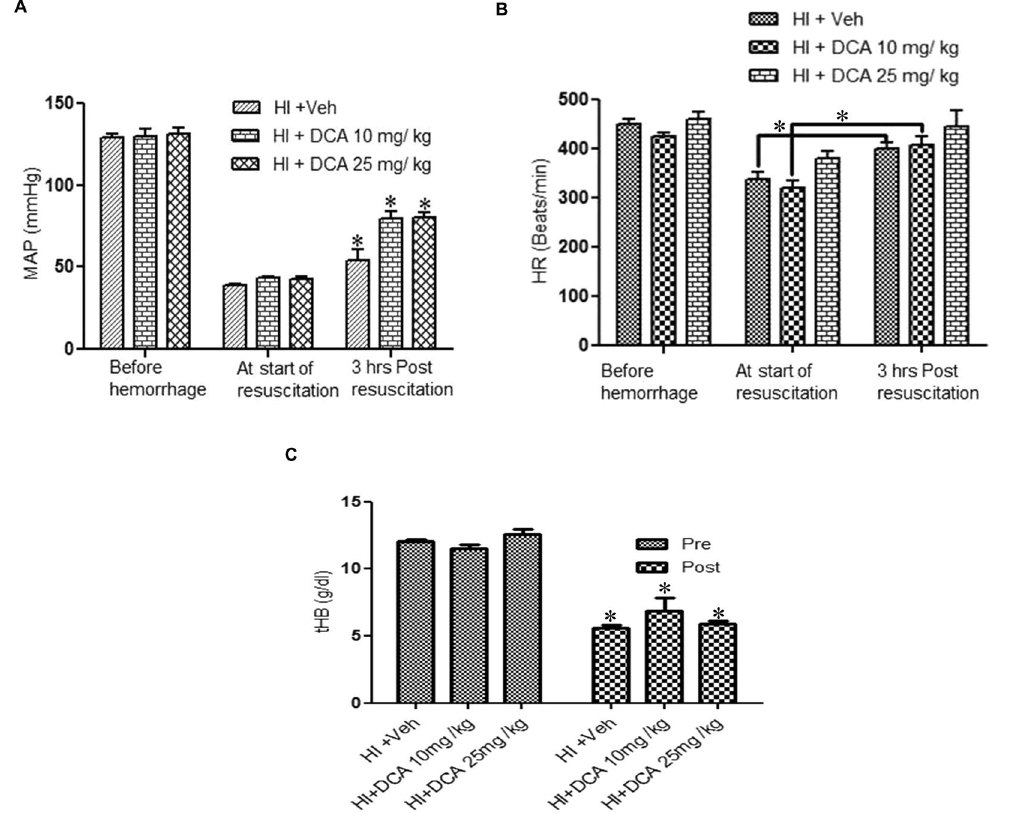
Figure 2. Hemodynamics following HI. ( A ) Mean arterial pressure (MAP). MAP before hemorrhage, at the start of fluid resuscitation and 3 hours post resuscitation. ( B ) Heart rate (HR). HR before hemorrhage, at the start of fluid resuscitation and 3 hours post resuscitation; groups. For panels A and B: HI + Veh (n = 8), HI + DCA 10 mg/Kg (n = 6) and HI + DCA 25 mg/Kg (n = 6). * p < 0.05 for respective groups compared to the MAP at the start of fluid resuscitation. ( C ) Blood Hemoglobin (tHB) levels before and at 3 hours post resuscitation in HI + Veh, HI + DCA 10 mg and 25 mg; n = 6. * Indicates p < 0.05 compared to